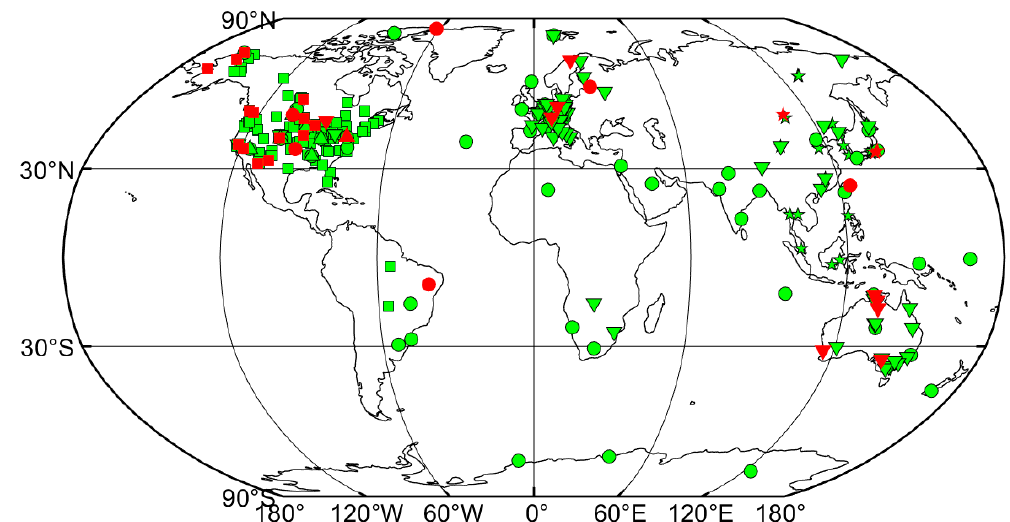
Figure 1. Geographical distribution of observation sites used to model (314 sites in total, green) and validate (35 sites in total, red) the L d dataset in this study collected at AmeriFlux (squares) with 159 and 16 sites, AsiaFlux (pentagrams) with 23 and 3 sites, BSRN networks (circles) with 51 and 6 sites, FLUXNET (inverted triangle) with 75 and 9 sites, and SURFRAD (positive triangle) with 6 and 1 sites, respectively.